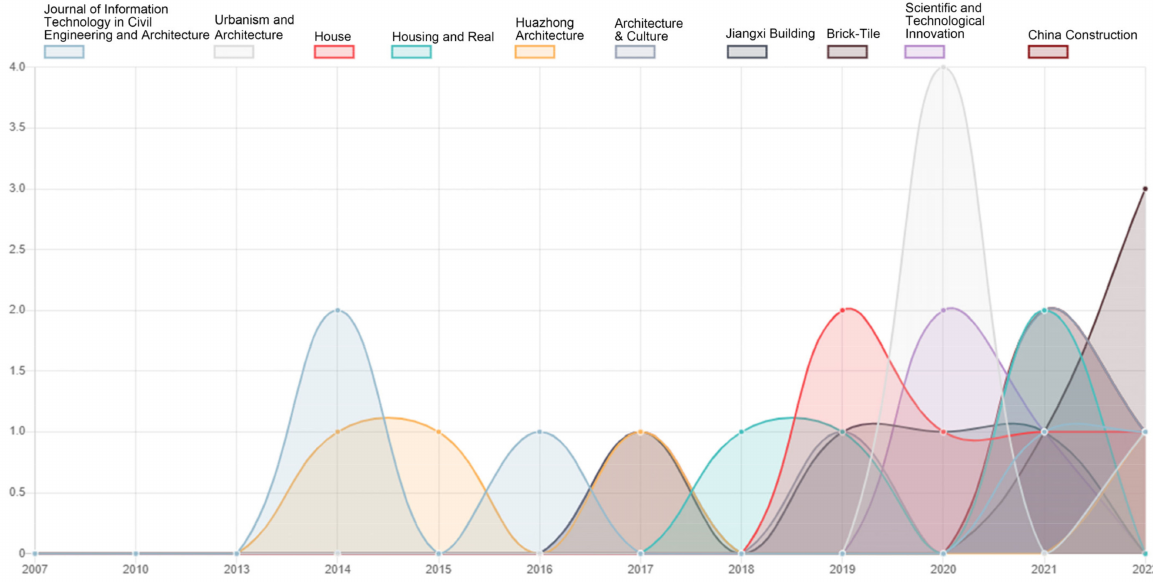
Figure 5. Distribution of journal publications on “BIM” and “architectural heritage” from 2007 to 2022 (186 articles).